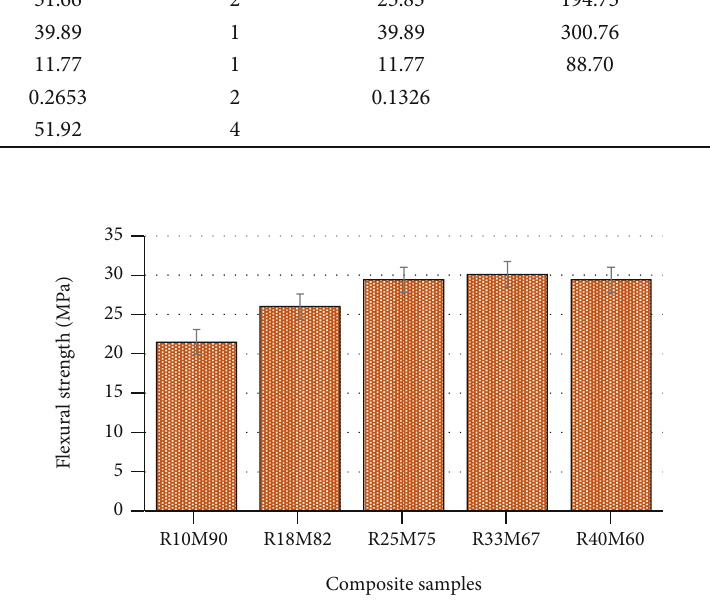
Figure 5: Flexural strength. Table 5: Impact strength.